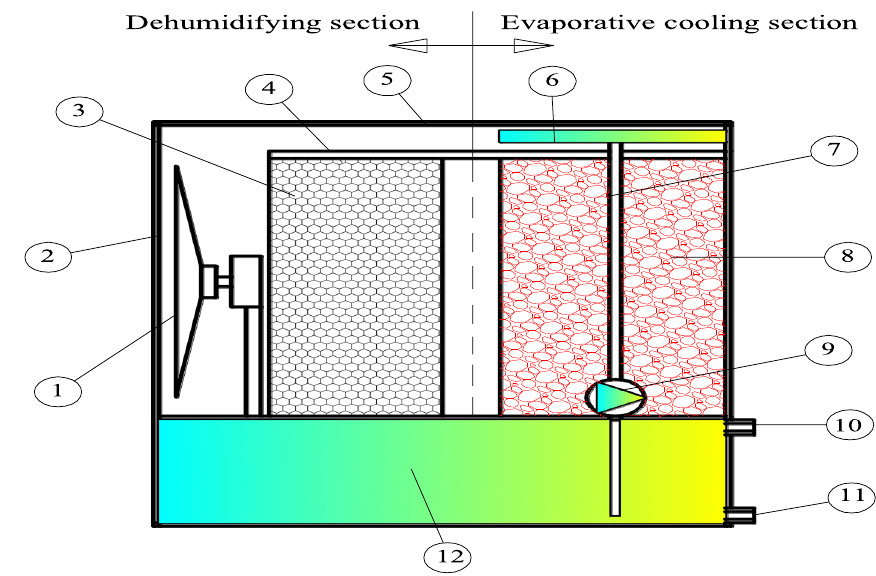
Fig. 2 Schematic of constructed modified direct evaporative cooling